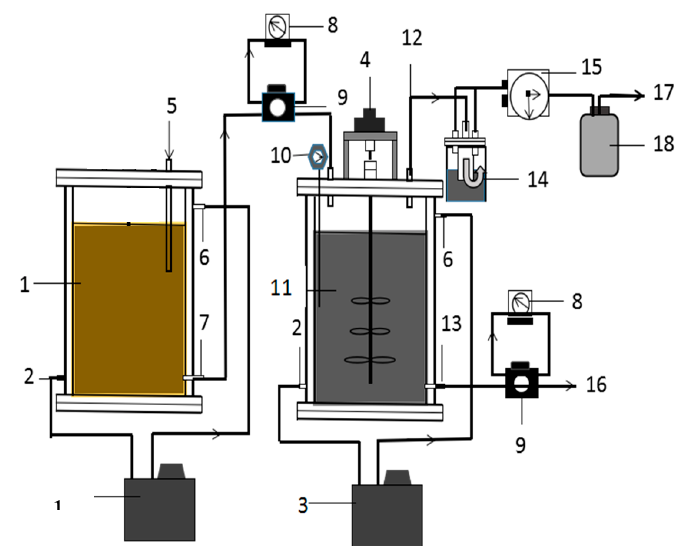
Figure 1. Scheme of the design of the present continuous stirred tank reactor (CSTR). 1. Substrate tank;